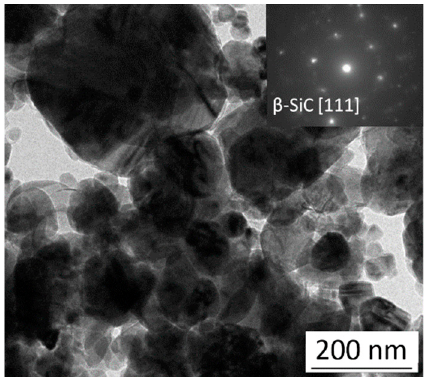
Figure 2. TEM image of spherical β -SiC nanoparticles with diameters ranging from 11 to 390 nm (average of 90 nm).